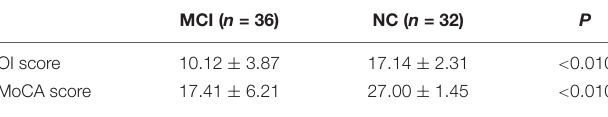
TABLE 2 | Comparison of behavioral score between MCI patients and